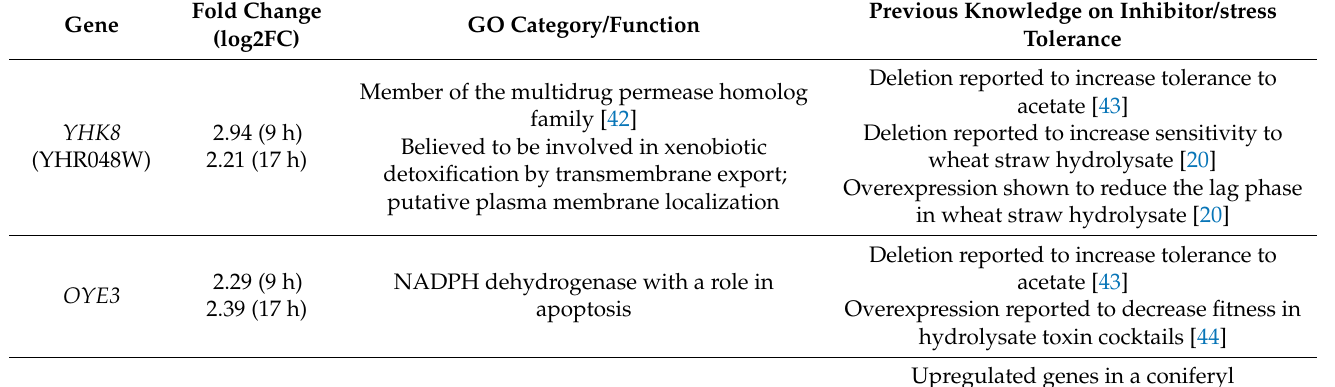
Table 4. Significantly up- or downregulated genes in spruce hydrolysate cell cultivation at both sam- pling times, and previous knowledge of their role in inhibitor or stress tolerance. GO classifications were obtained from SGD (https://www.yeastgenome.org/; [32]), unless noted